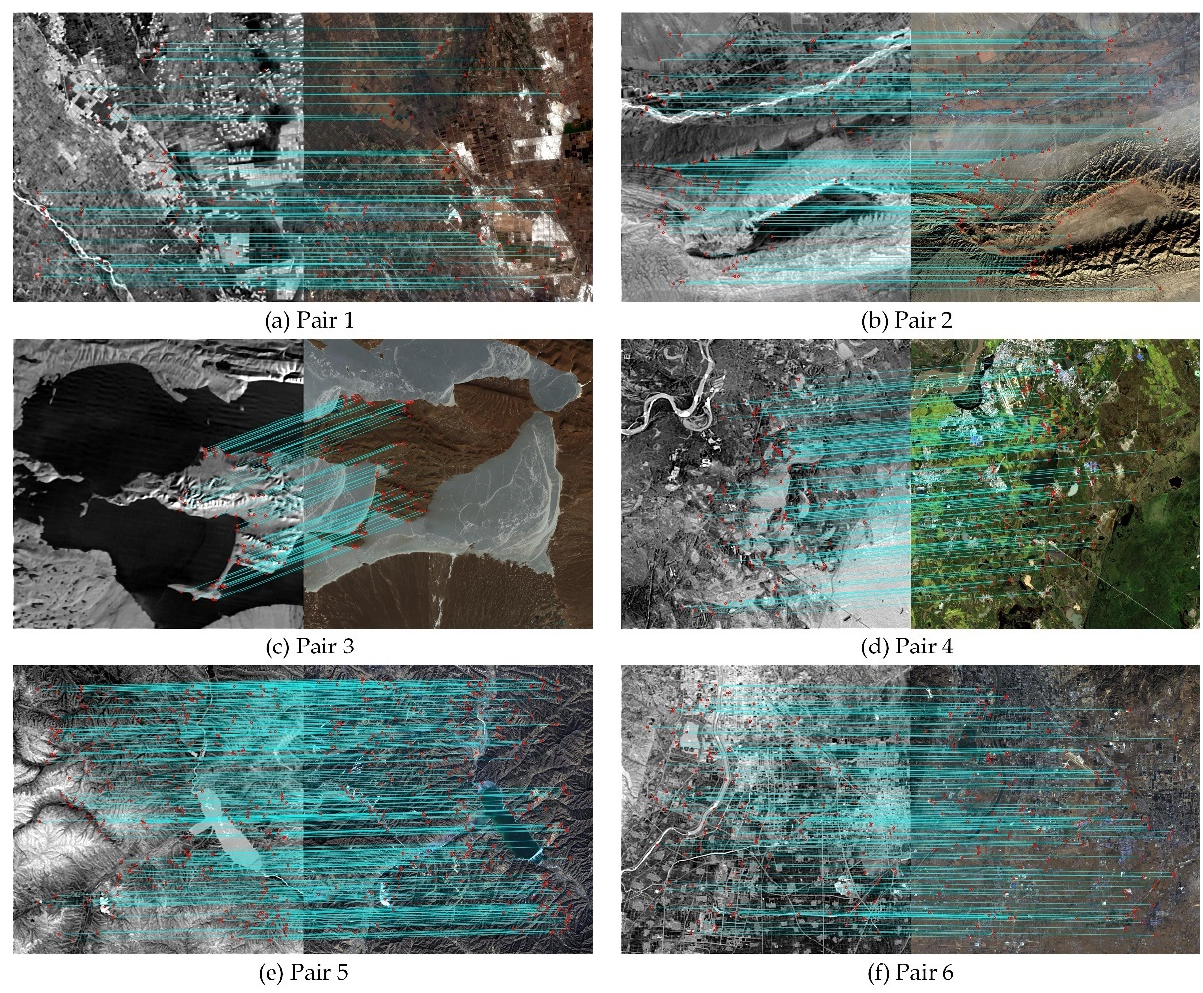
Figure 6. The registration results of modified RIFT. In each image pair, the image on the left is TIR image and the image on the right is visible reference image. All the images are 1000 × 1000 pixels.